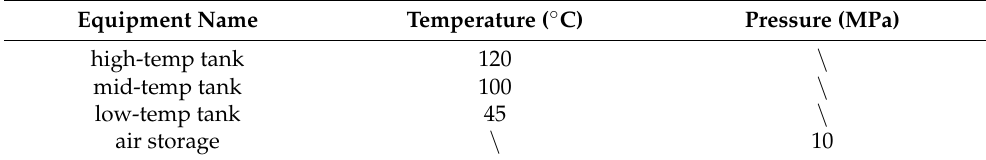
Table 2. Equipment parameters of TICC-500.